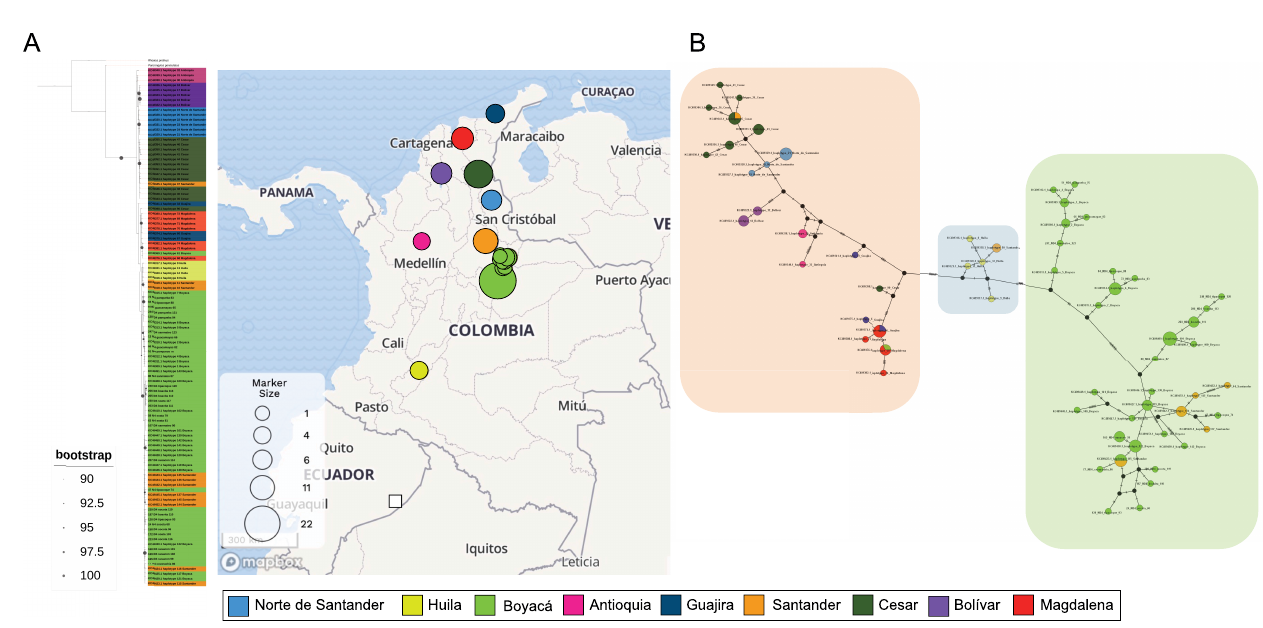
Fig 2. Maximum Likelihood phylogenetic reconstruction and haplotype analyses for ND4 genetic marker. A) shows the phylogenetic relationship between ND4 sequences obtained from GenBank (74) and in the present study (33). The map was made using Microreact [51] Maps Mapbox (www.mapbox.com/ about/maps) and OpenStreetMap (www.openstreetmap.org/about). Circles’ size in the map is related to the number of sequences used for the analysis. The tree was rooted with Rhodnius prolixus and Panstrongylus geniculatus mitochondrial partial sequences. B) Haplotype network of ND4 sequences. Green box groups (Boyaca´ and Santander haplotypes), blue box groups (Huila haplotypes (southwest)), and orange box groups (the haplotypes belonging to northern Colombia).